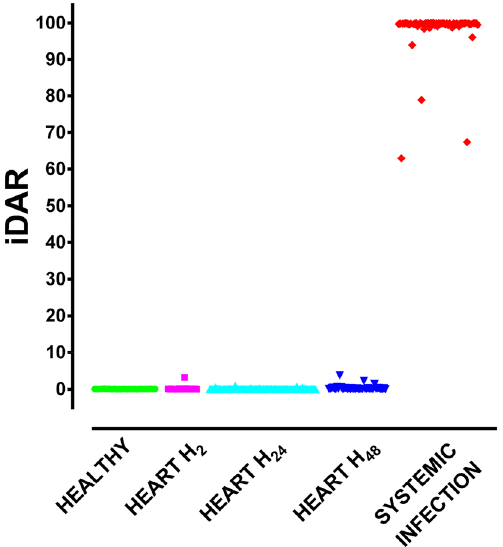
Figure 3. iDAR score values in the 5 patient groups of the discovery